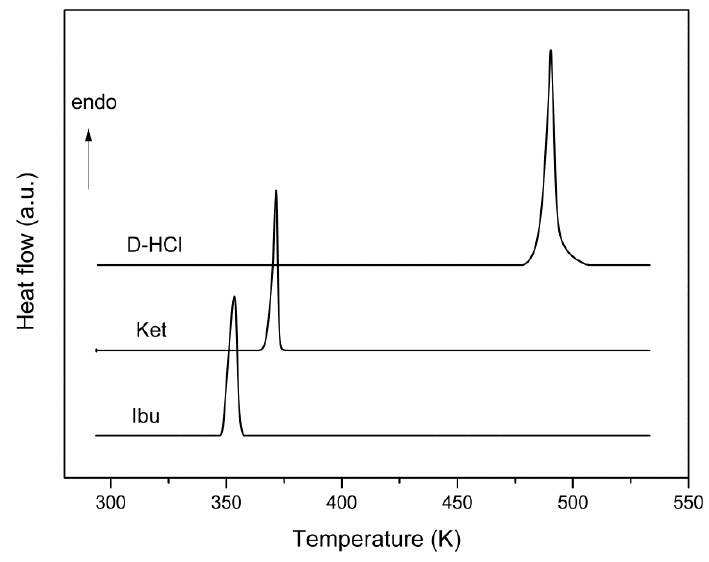
Figure 2. DSC curves for Ibuprofen (Ibu), Ketoprofen (Ket) and Drotaverine Hydrochloride (D-HCl).